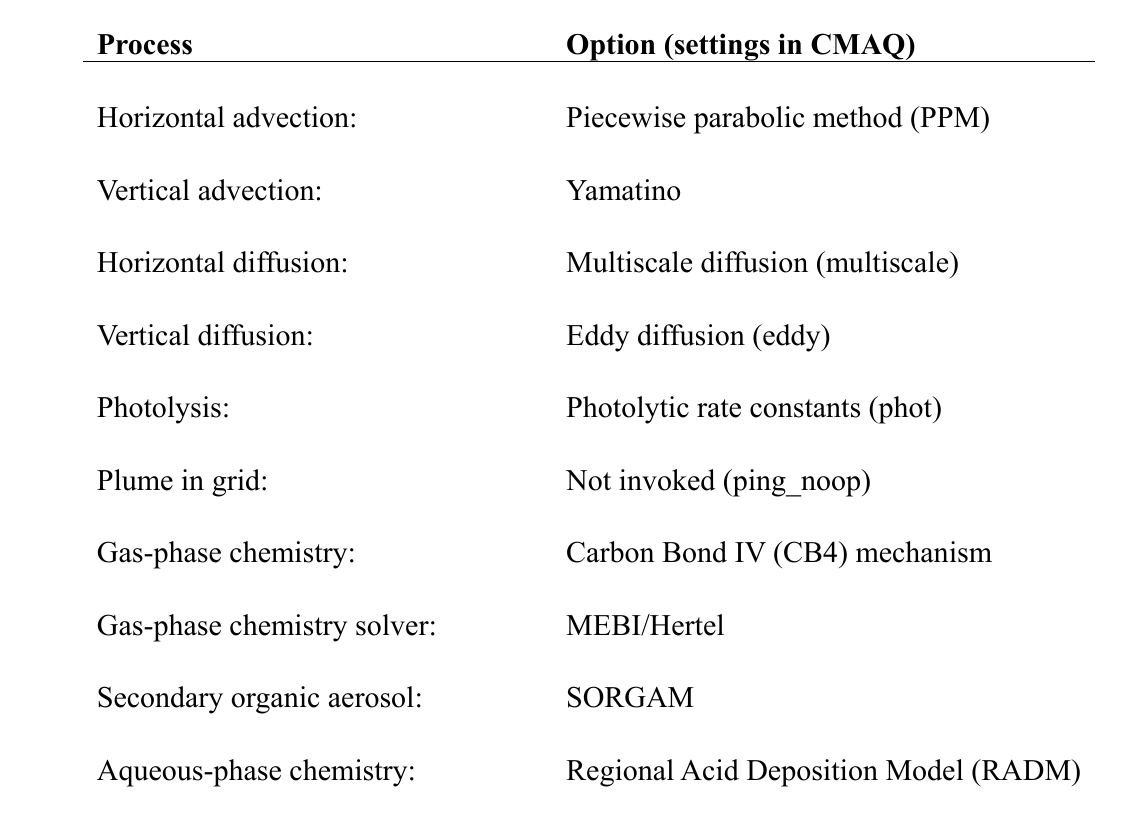
Table 1. The major processes used in